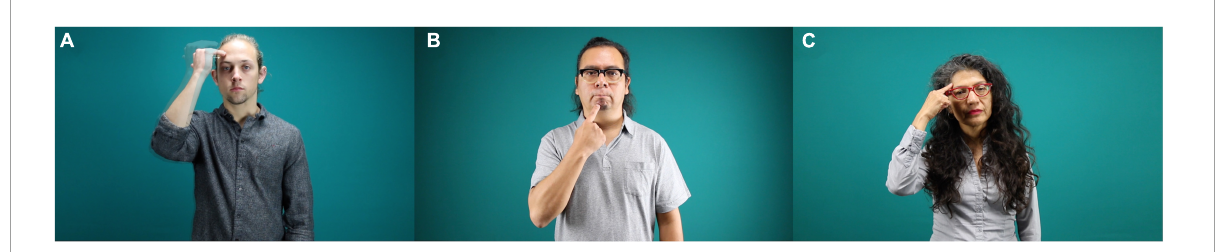
FIGURE1 Minimal pairs in American Sign Language (ASL) (figures reproduced with permission from ASL Signbank; Hochgesang et al., 2021). (A) KNOWbb; (B) DISAPPOINT; and (C)